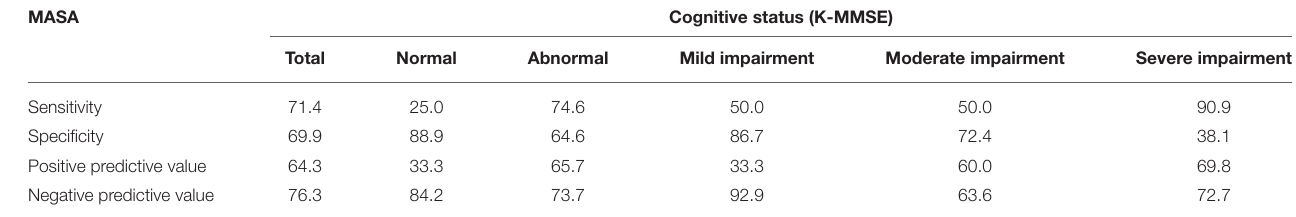
TABLE 3 | Accuracy of MASA for prediction of aspiration according to cognitive status.